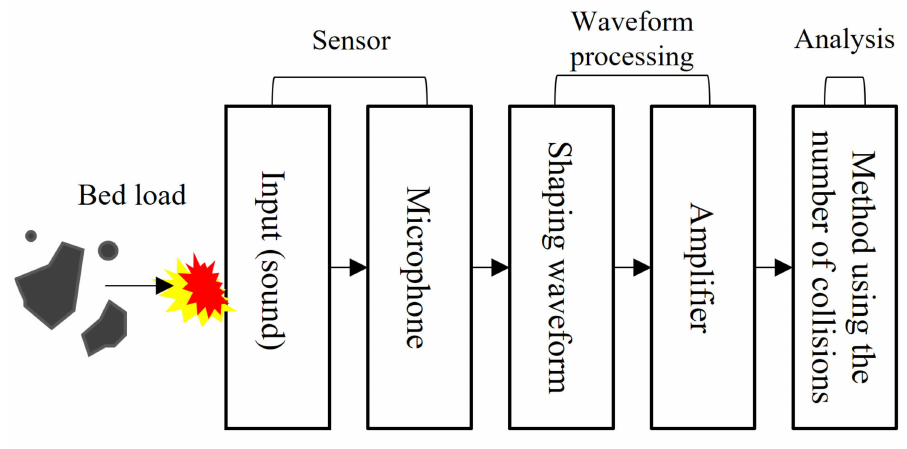
Figure 2. Configuration and operational flow diagram of the pipe hydrophone system.